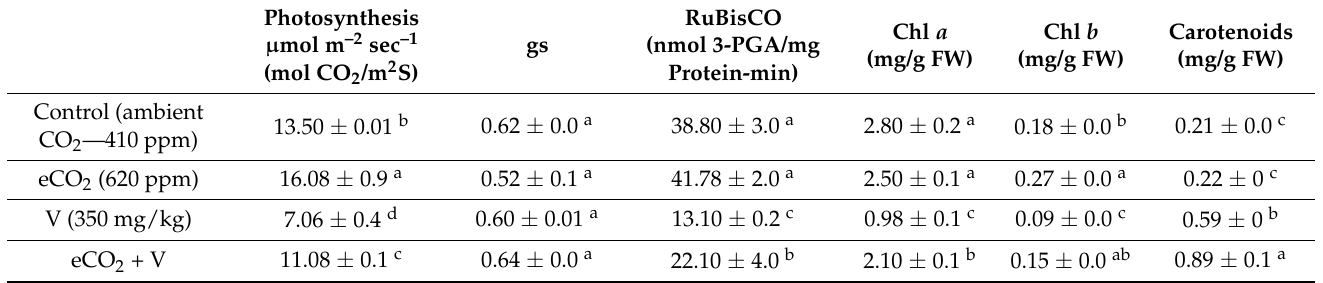
Table 1. Effect of elevated CO 2 (eCO 2 ), vanadium (V) and their combination on (A) chl a (mg/gFW), (B) Chl b (mg/g FW), (C) carotenoids (mg/g FW) (D), photosynthesis (Asat; mol CO 2 /m 2 S), (E) stom- atal conductance (gs; nmol CO 2 m − 2 s − 1 ), and (F) RuBisCO (nmol 3-PGA/mg protein. min) of wheat. Data are mean values ± SE ( n = 4). Using Fisher’s LSD test, the data for each group were compared pairwise ( p < 0.05; n = 4). Different letters indicate that there is a significant difference between the treatments.